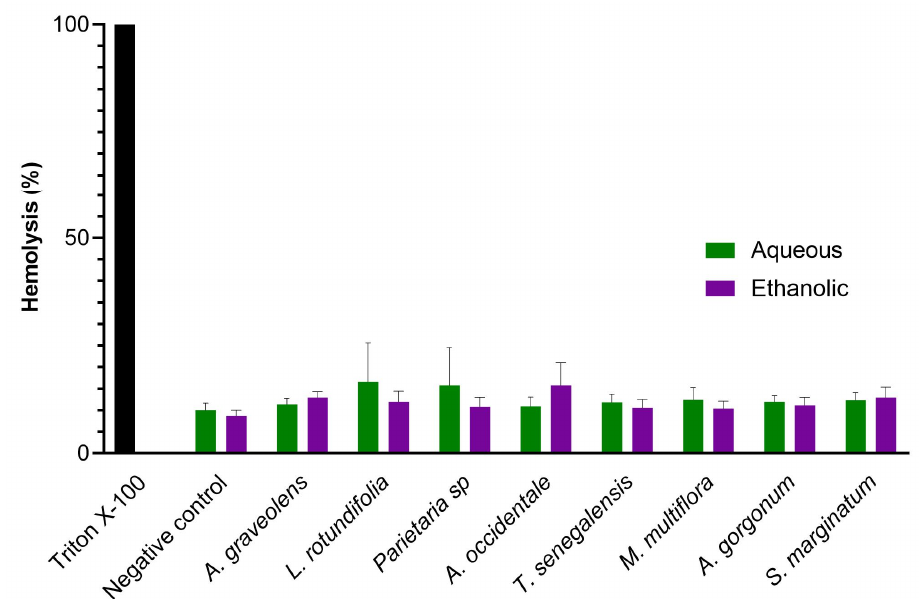
Figure 2. Hemolysis was measured in the presence of erythrocytes incubated with extracts at 50 µ g/mL after 24 h. Triton X-100 was used a positive control. The data are derived from two independent experiments. Table 3. In vitro cytotoxicity activity of the ethanolic and aqueous extracts.